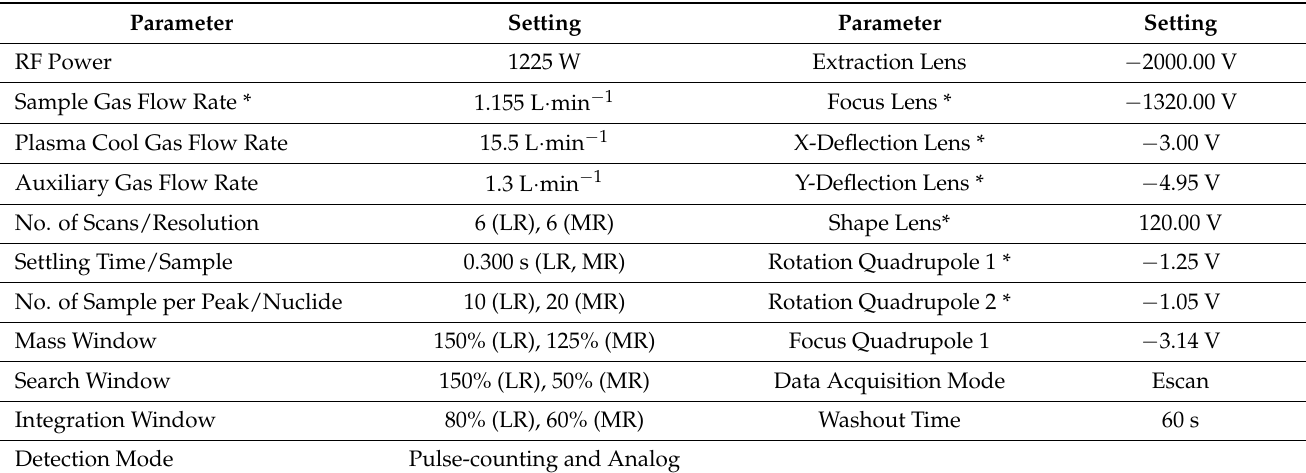
Table 4. Operating settings for the ELEMENT2™